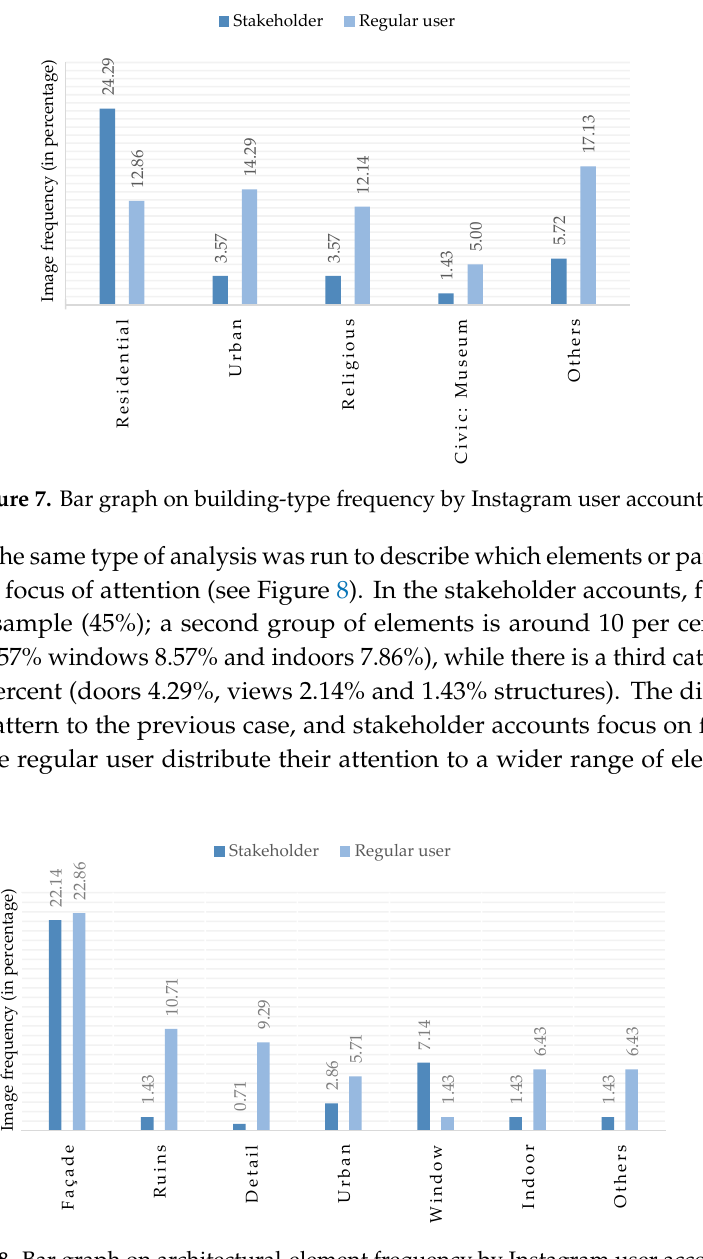
Figure 8. Bar graph on architectural-element frequency by Instagram user account.